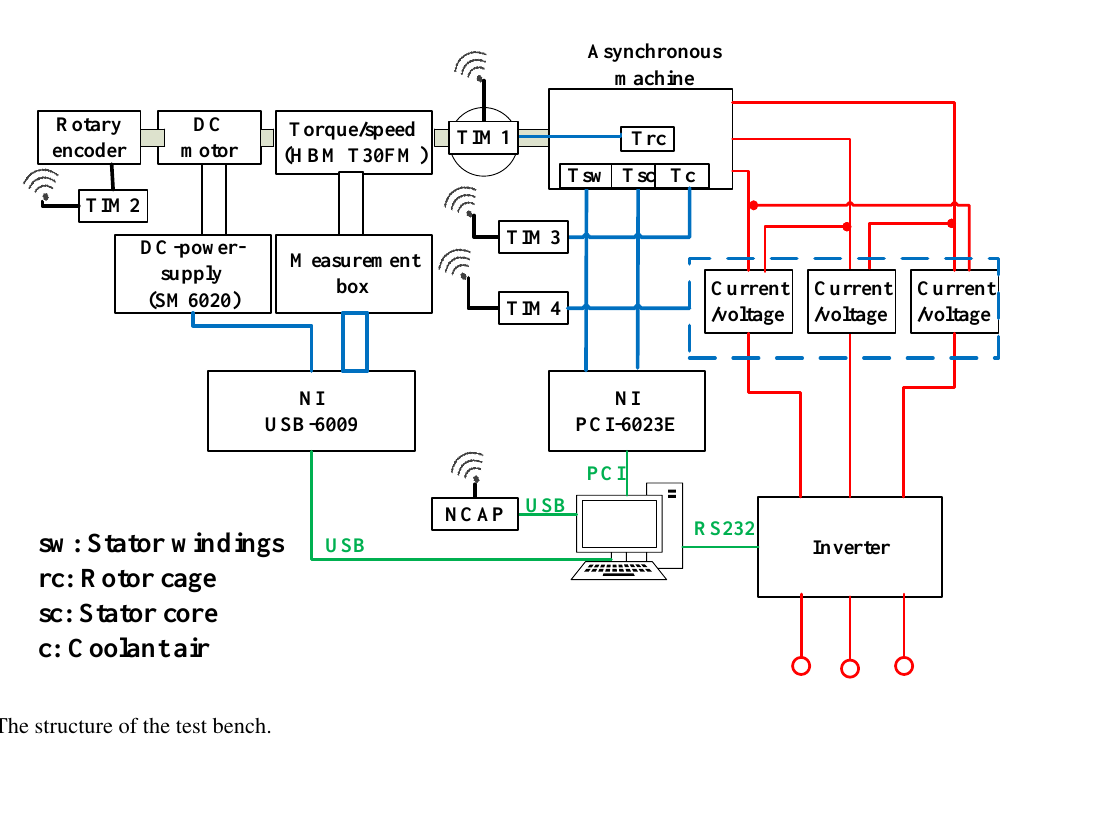
Figure A1. The structure of the test